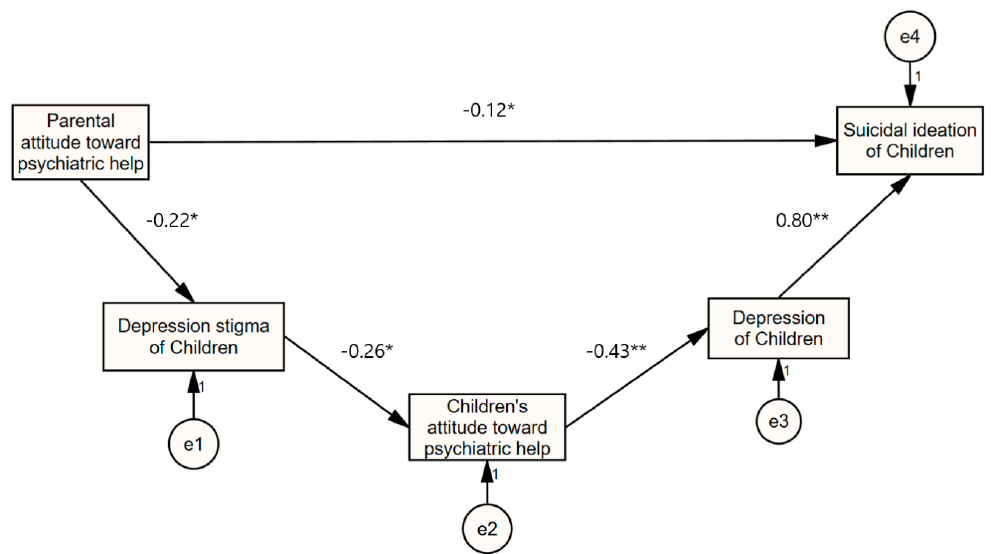
Figure 1. A serial mediation analysis: Mediating effects of depression stigma, attitude toward psychiatric help, and depression in children in the relationship between parental attitude toward <